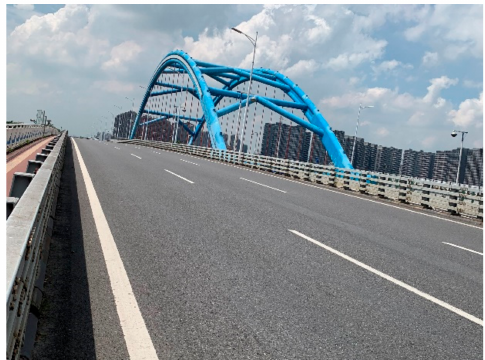
Figure 17. Current situation of the case